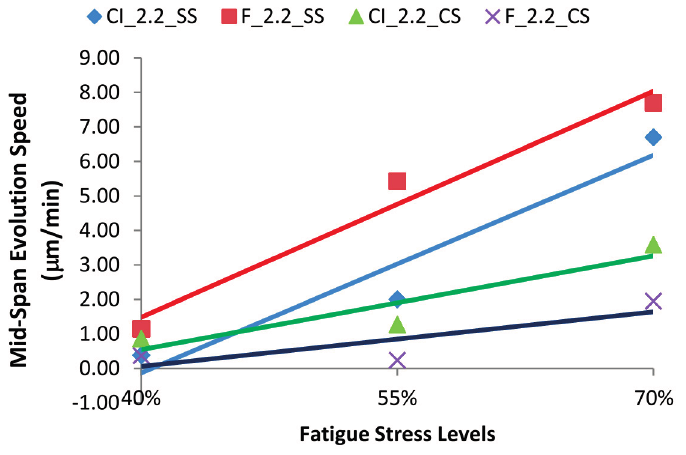
Figure 4. Speed rate of mid-span evolution at different fatigue stress